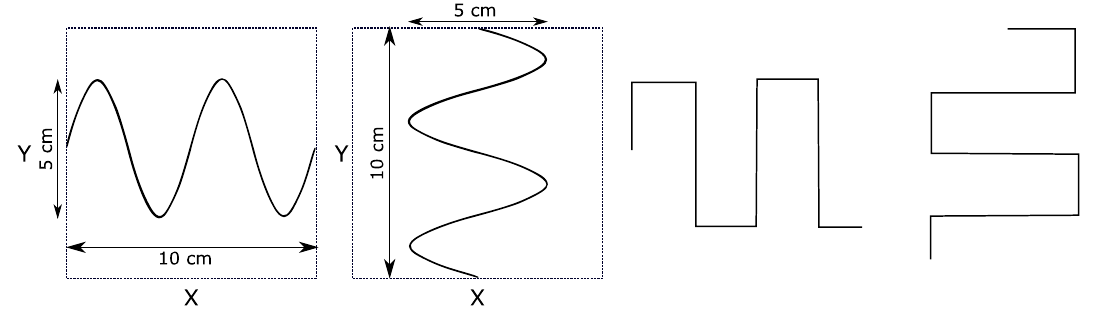
Figure 6. The four haptic pathways used in the second experiment. The box enclosing the pathways represents the 10 × 10 cm workspace.